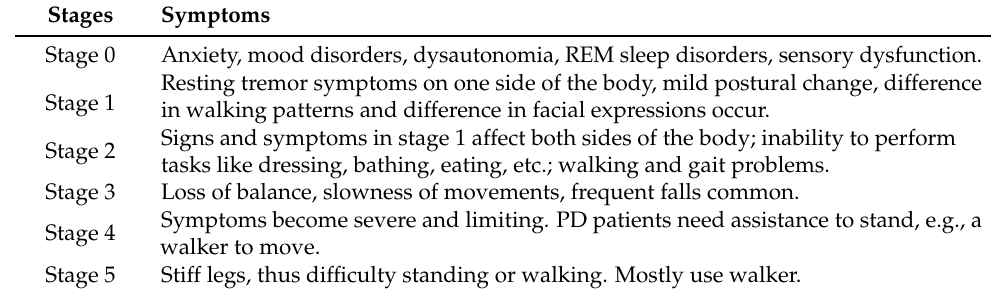
Table 1. Various stages and symptoms of PD